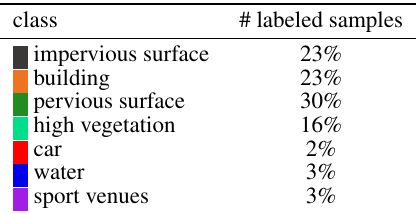
Table 2. Number of labeled samples (in percentage) in the semantic segmentation ancillary data.